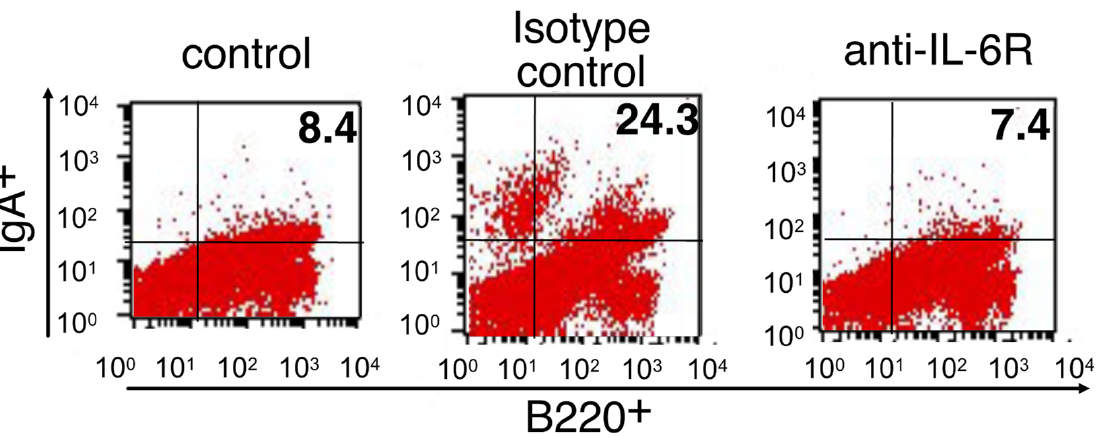
Figure 4. Influence of anti-IL-6R blocking antibodies on the differentiation into IgA + B cells in the nasal passage induced by CpG ODN-loaded cationic liposomes. BALB/c mice were intraperitoneally treated with anti-IL-6R antibody (250 μ g/mouse) or the respective isotype control antibody (250 μ g/mouse) two days prior to the first immunization (day -2) and 1 h prior to each subsequent immunization (days 0 and 7). Mice were then immunized intranasally with PBS or OVA (5 μ g/mouse) in combination with CpG ODN-loaded cationic liposomes (10 μ g/mouse as CpG ODN) at a volume of 13 μ L twice weekly. A week after the last immunization, IgA + B cells in the nasal passage were analyzed by flow cytometry. Control, n = 4; isotype control, n = 4; anti-IL-6R mAb, n = 4.